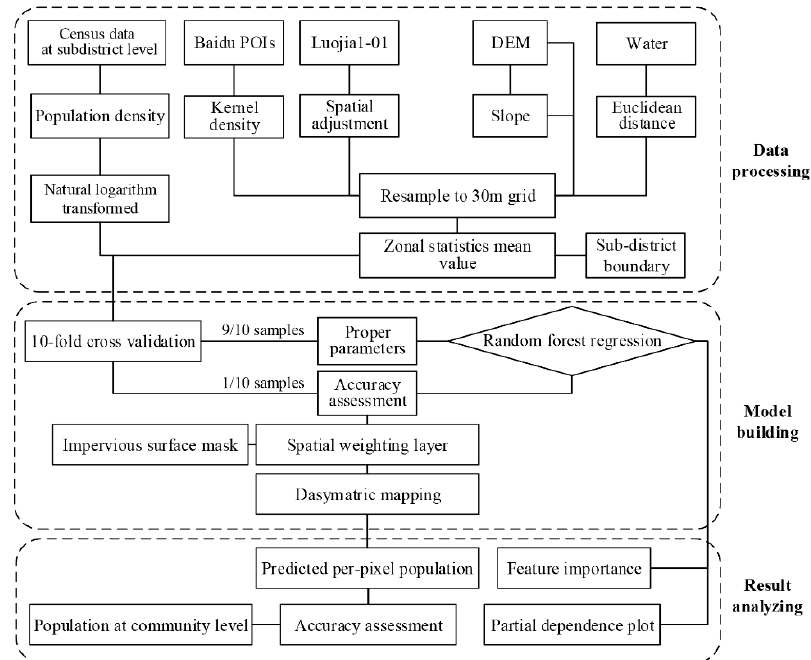
Figure 2. Workflow of disaggregating the census population into 30-m-grid cells.